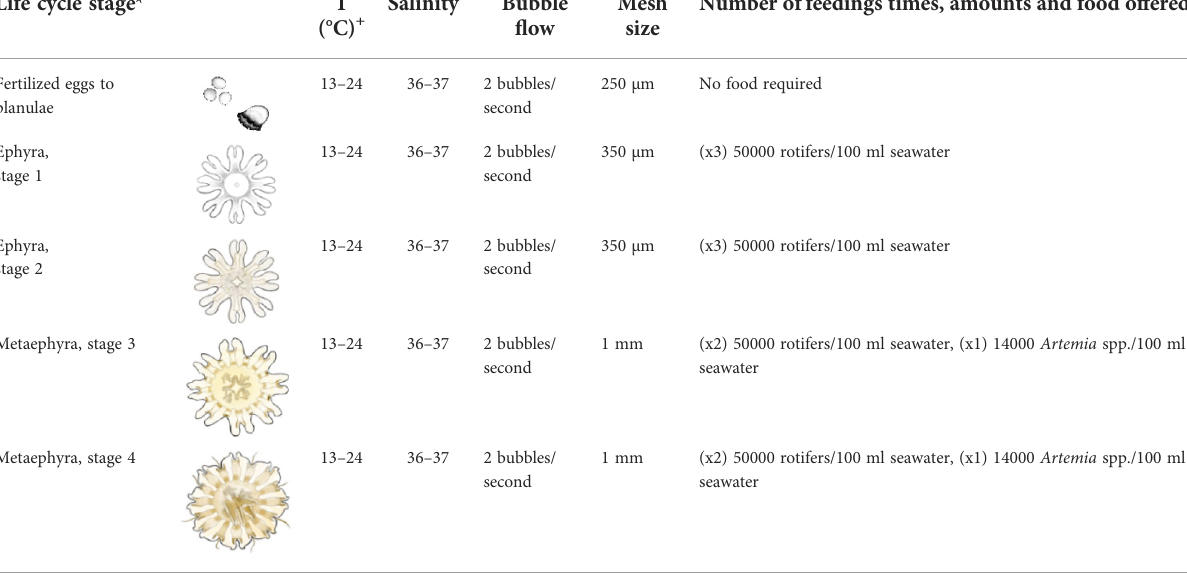
TABLE 2 Culture conditions for Pelagia noctiluca early life stages in fl ow-through system. Life cycle